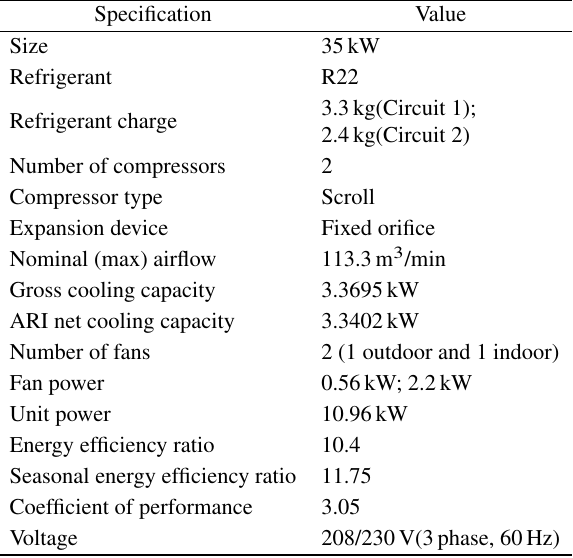
Table 1 Rooftop unit